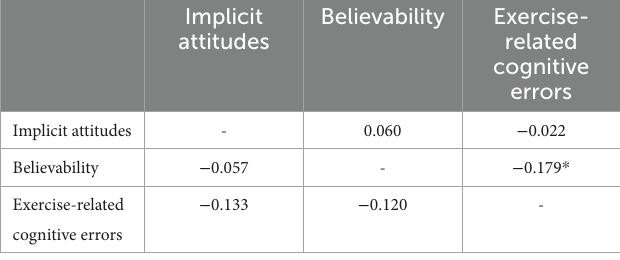
TABLE 2 Correlations between continuous variables in study one; Results for men are below the diagonal and the women’s results are above the